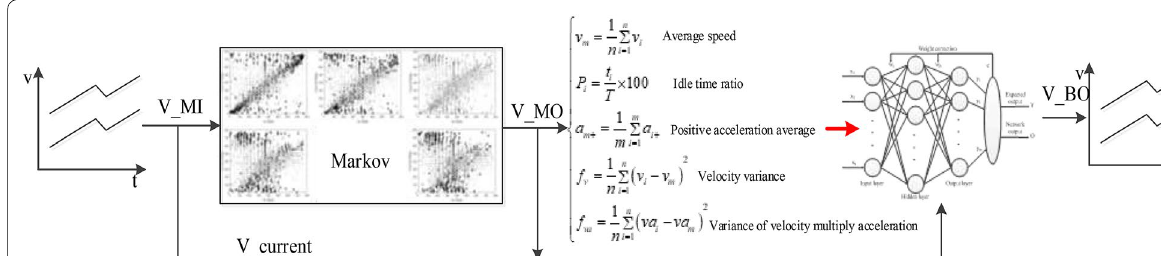
Figure 8 MBNN1 combined prediction model